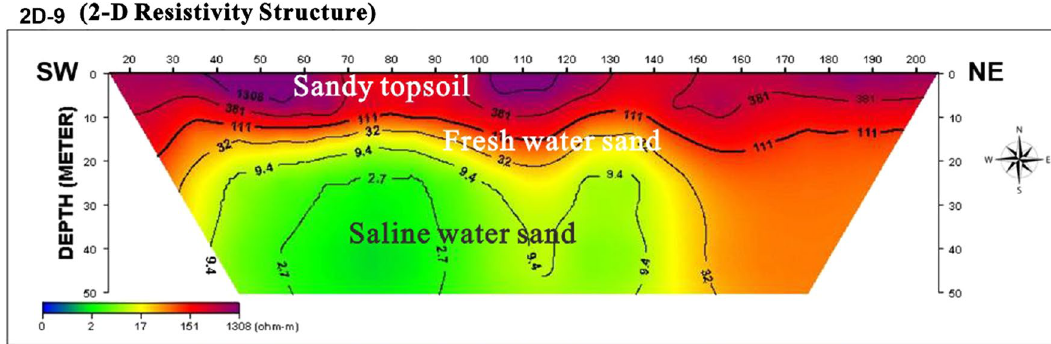
Fig. 13 Resistivity imaging of Traverse